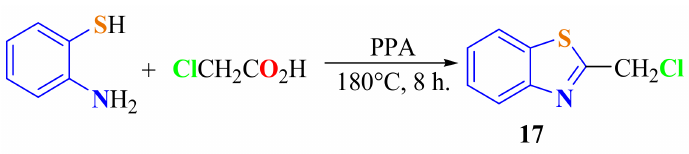
Scheme 9. Condensation to access